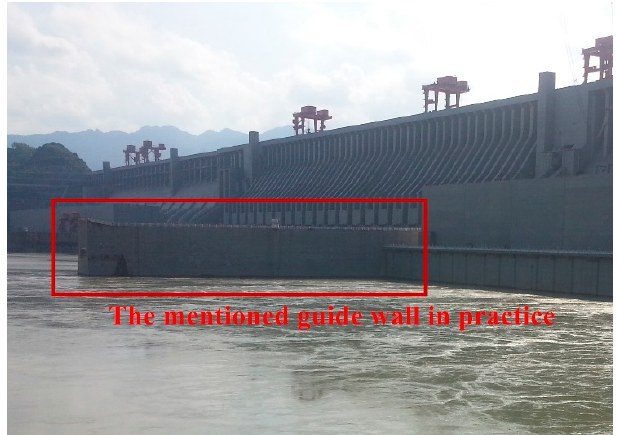
Figure 5. The left guide wall of TGHS in still water.